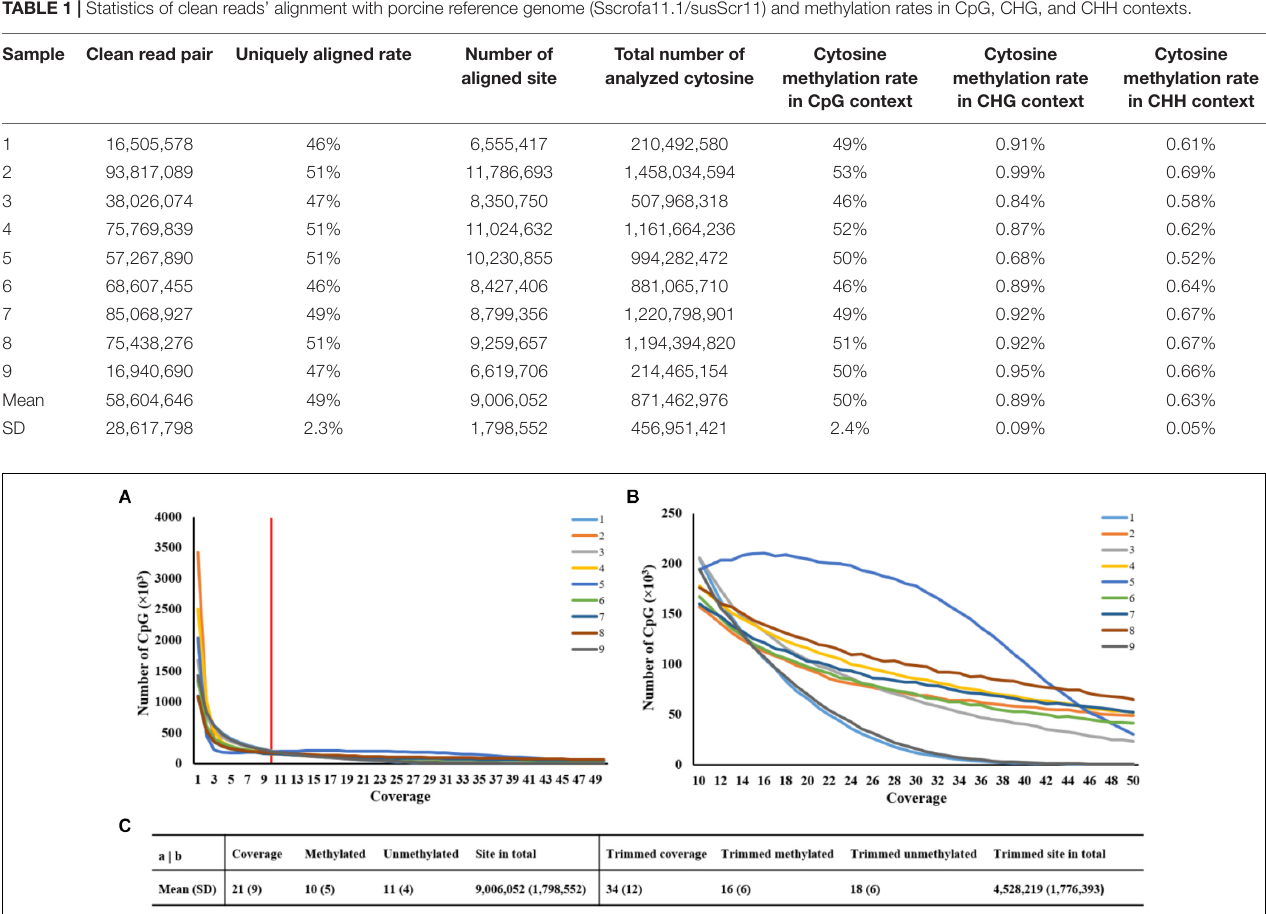
FIGURE 1 | Statistics of averaged coverage in CpG context. (A) Number of CpG sites at different coverage of original data. Note: Red line indicated the coverage at 10. (B) Number of CpG sites at different coverage of trimmed data. (C) Comparison of statistics of averaged coverage between original and trimmed data.